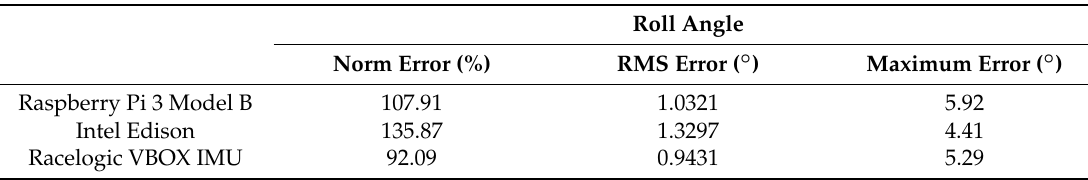
Table 8. Test 3. Processing time on Raspberry Pi 3 Model B and Intel Edison.